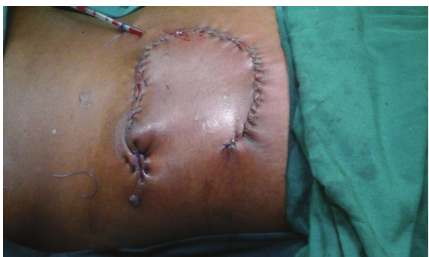
Figure 5: Wound completely covered with the fasciocutaneous flap with a drain in situ.